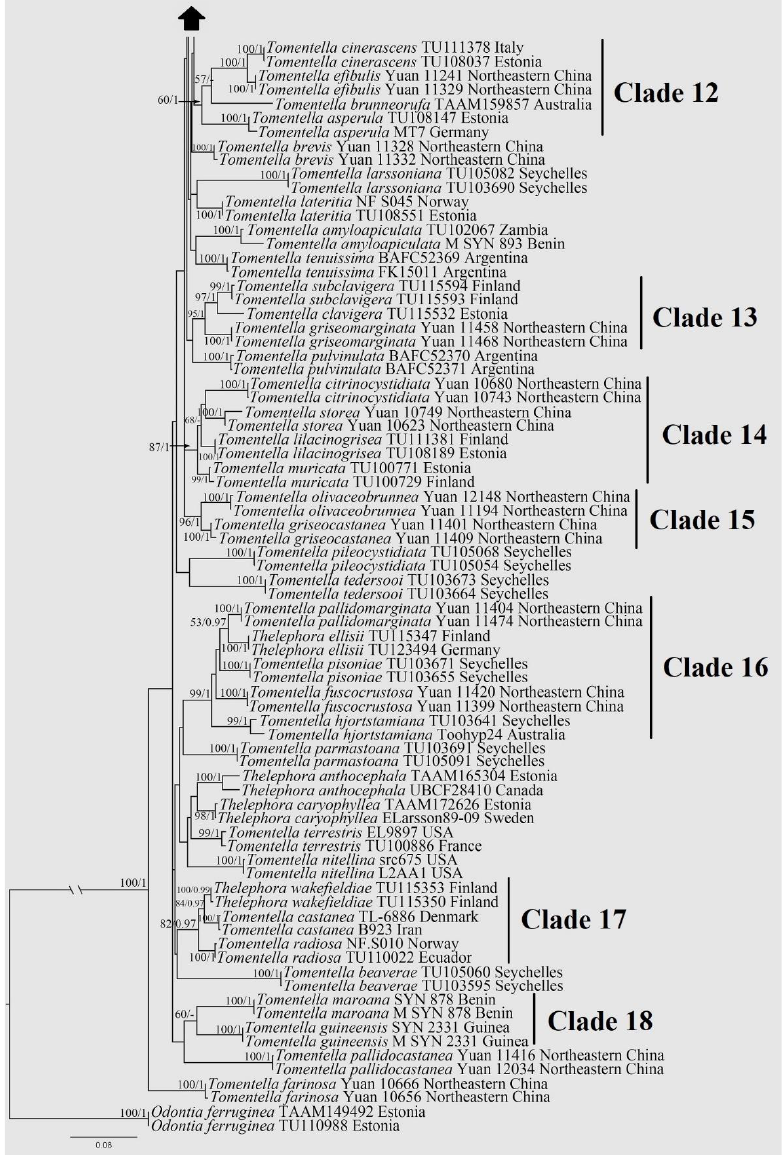
Figure 1. Maximum likelihood tree illustrating the phylogeny of Tomentella aurantispora , T. kanasensis , T. schrenkiana , and related taxa based on ITS + LSU nuclear rDNA sequences dataset. Branches are labeled with maximum likelihood bootstrap higher than 50% and Bayesian posterior probabilities higher than 0.95. The terminals indicate the regions where they were distributed. New species are in bold (black).